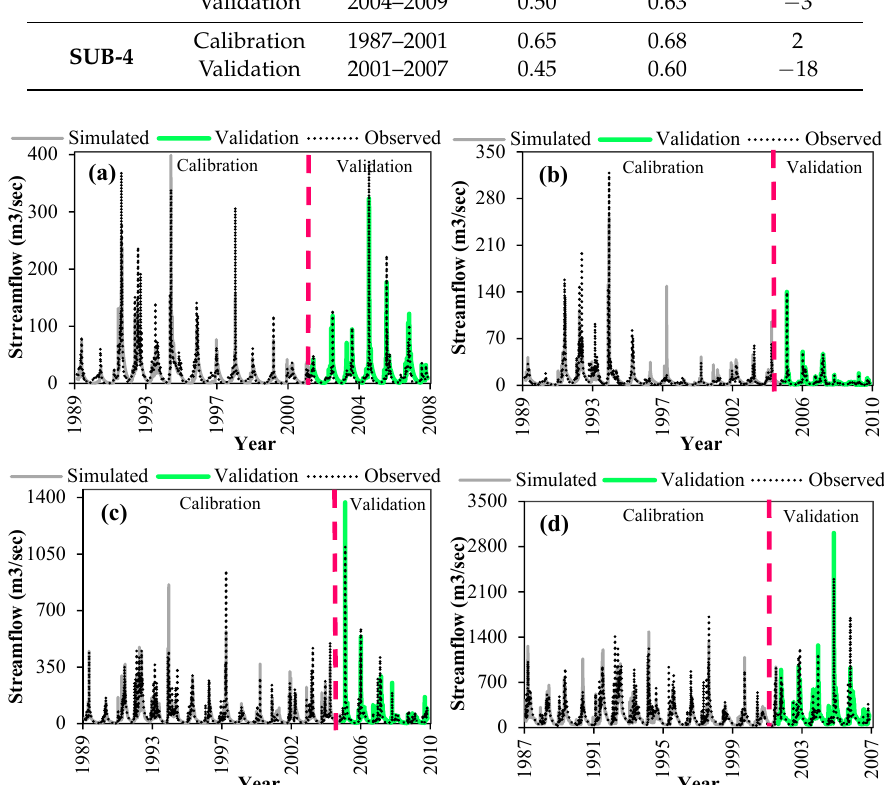
Figure 4. The observed and simulated streamflow during the calibration and validation periods in the sub-basins: SUB-1 ( a ); SUB-2 ( b ); SUB-3 ( c ); and SUB-4 ( d ). The striped line shown on the graphs separates the calibration and validation periods.